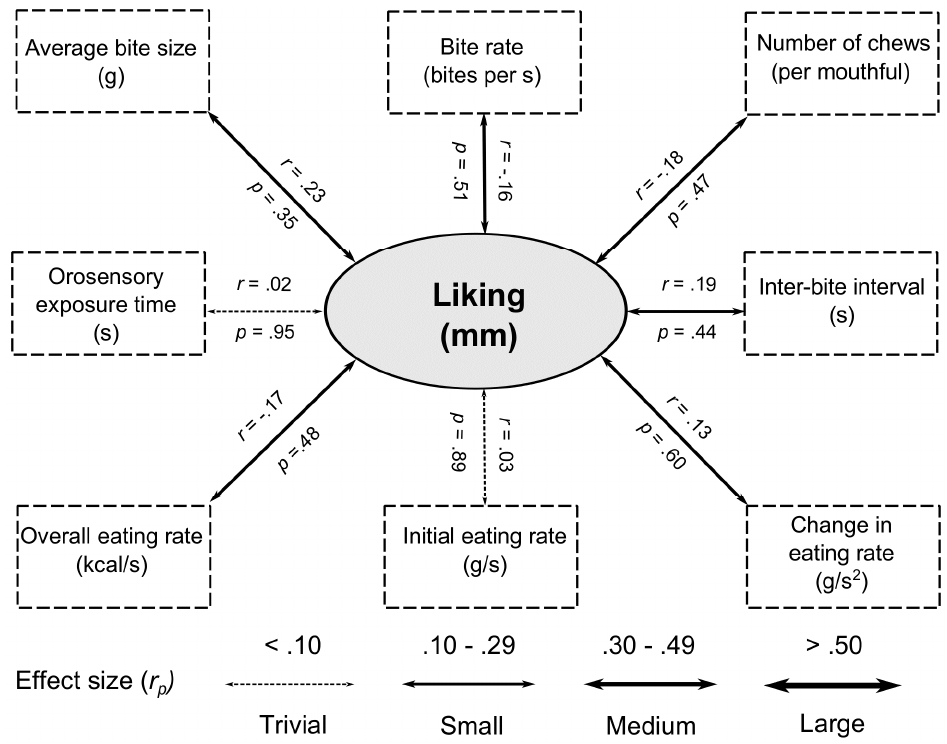
Figure 2. Partial correlations ( r p , controlling for baseline composite fullness) between oral processing behaviours and food liking (mm). Effect sizes are denoted by the width of each arrow.